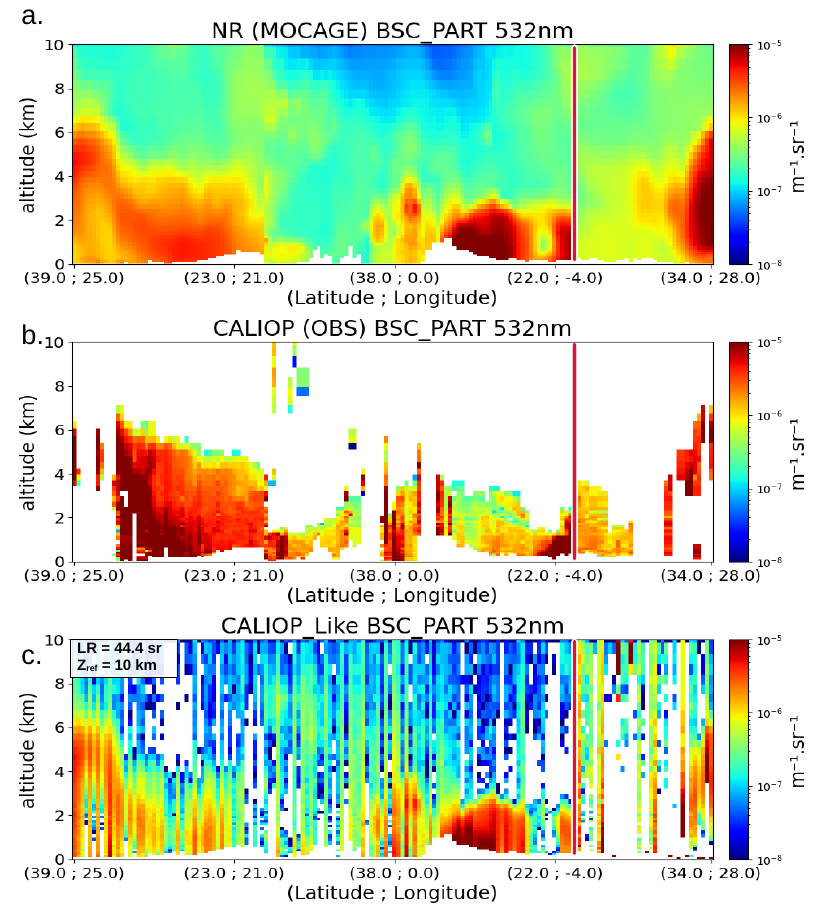
Figure 5. Comparison of particular backscatter coefficient transects at 532 nm along the trajectory of CALIOP for 22 March 2018, over the Medit region. ( a ) Transect from the NR, ( b ) CALIOP observations, and ( c ) the corresponding CALIOP_Like SO. The vertical red line corresponds to the start of the daytime orbit